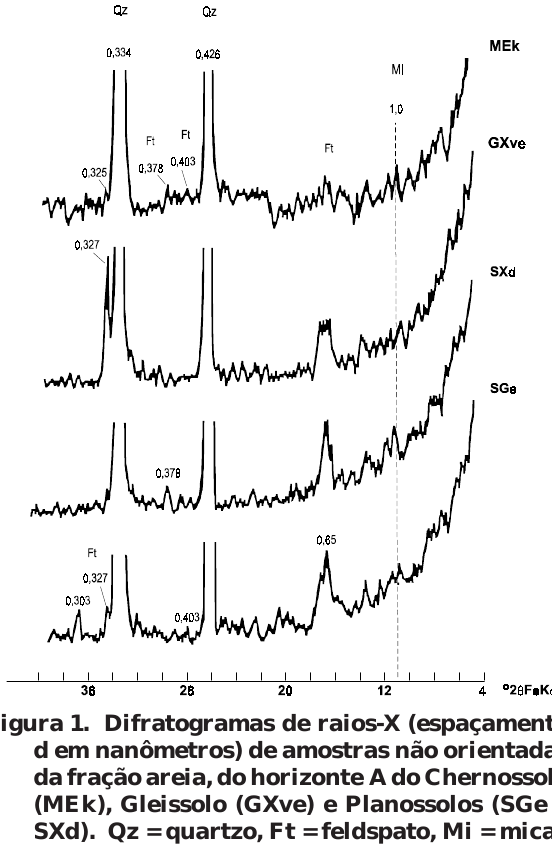
Figura 2. Difratogramas de raios-X (espaçamento d em nanômetros) de amostras não orientadas da fração silte, do horizonte A do Chernossolo (MEk), Gleissolo (GXd) e Planossolos (SGe e SXd). Qz = quartzo, Ft = feldspato, Mi = mica, Es =